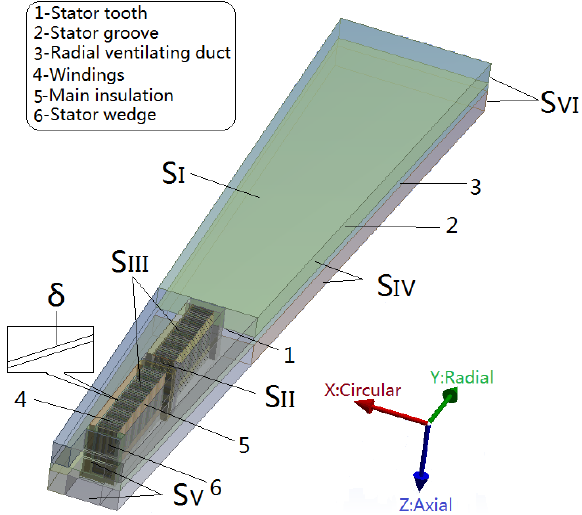
Figure 2. Stator temperature field calculation model and boundary conditions.